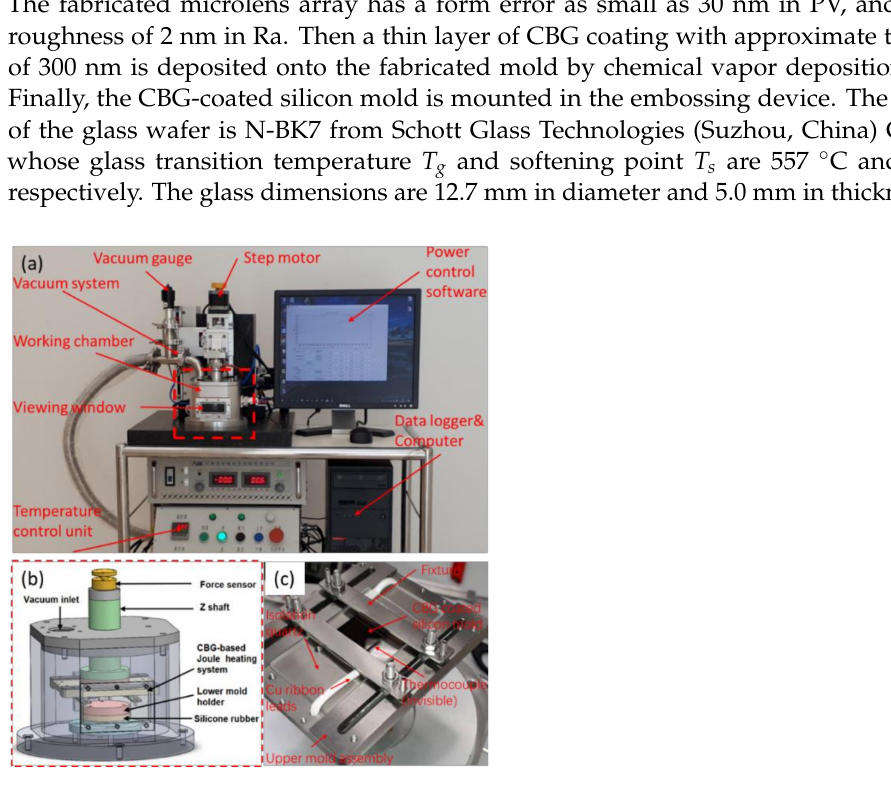
Figure 4. Hot embossing apparatus: ( a ) main components, ( b ) working chamber, ( c ) upper assembly with CBG-coated silicon mold.